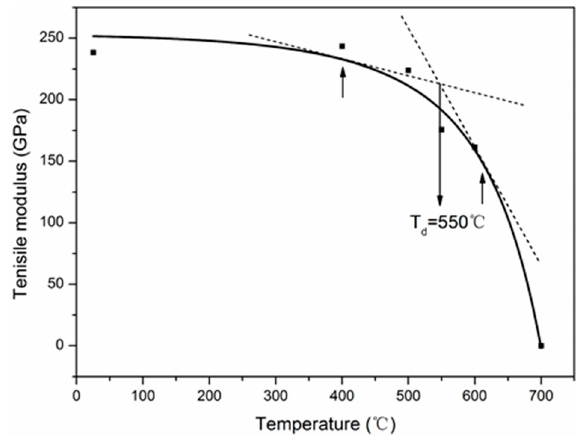
Figure 13. Variation of tensile modulus with the exposure temperature .